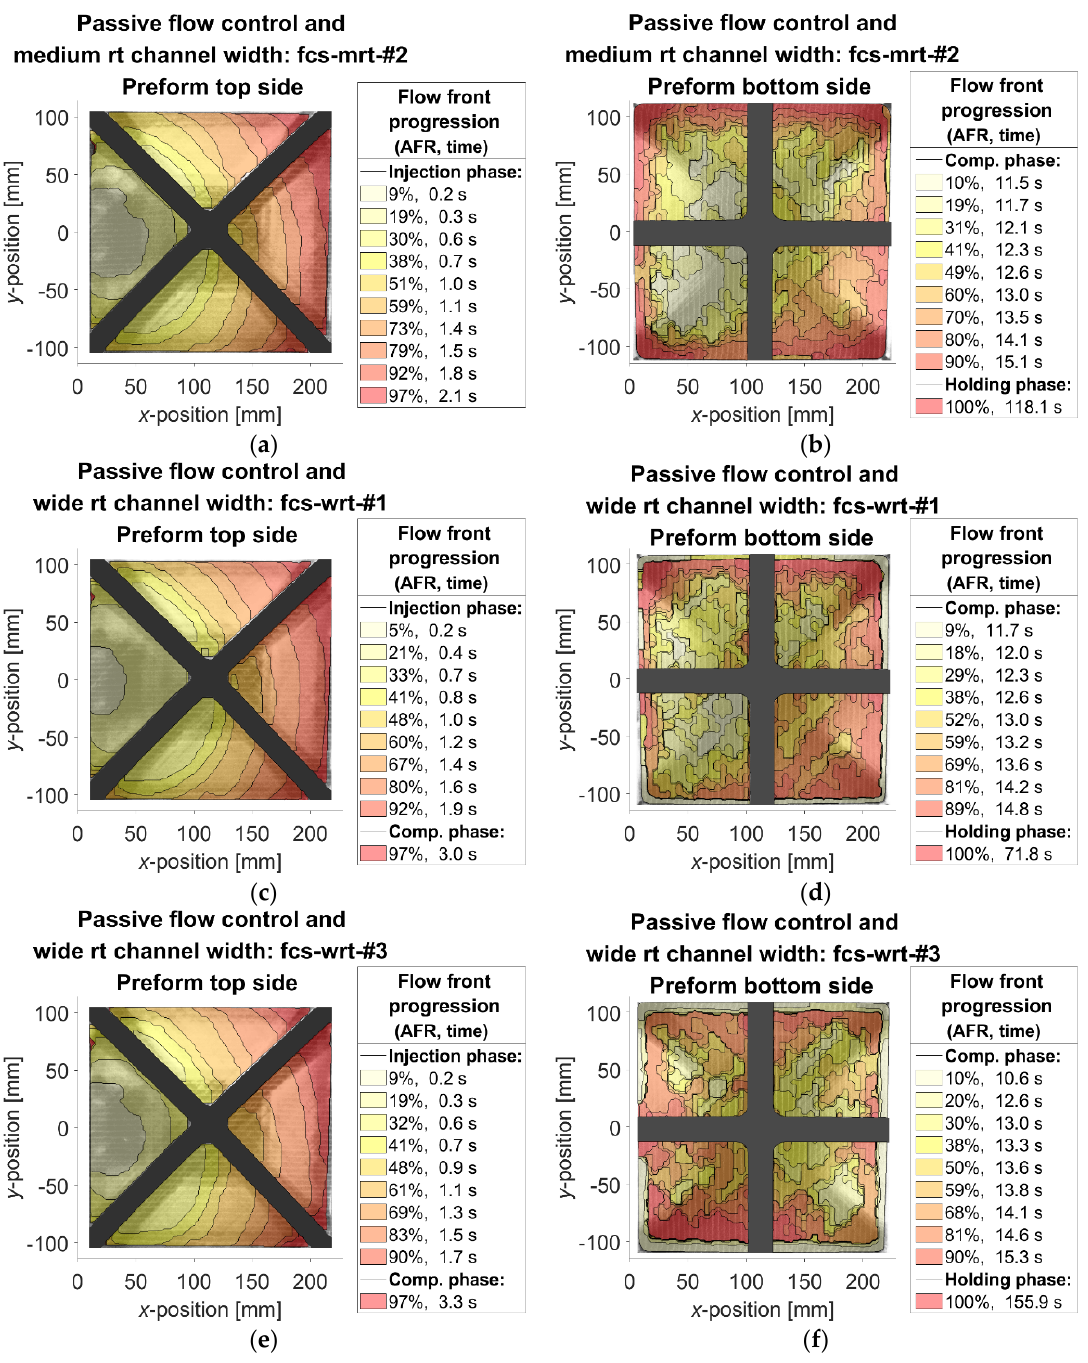
Figure A10. Flow front progression of FS-CRTM experiments of the flow control study: ( a , b ) medium race-tracking (rt) channel width—fcs-mrt-#2; ( c , d ) wide race-tracking channel width—fcs-wrt-#1; ( e , f ) wide race-tracking channel width—fcs-wrt-#3 (AFR = area filling ratio).